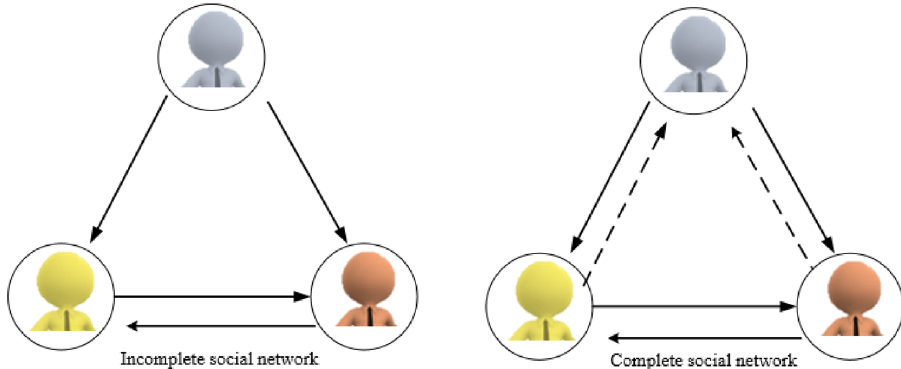
Fig. 1 The two types of the social